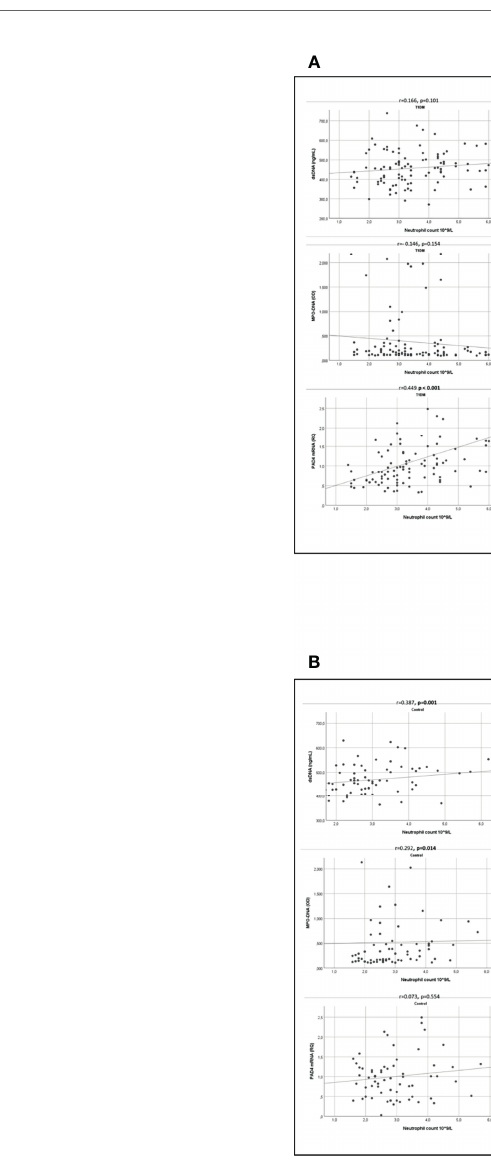
FIGURE 5 | Correlation between NETs markers and neutrophil count. Scatter graphs with trend line showing correlations between markers of NETs and neutrophil count in TIDM (A) and controls (B) . T1DM, type 1 diabetes mellitus; dsDNA, double-stranded deoxyribonucleic acid; MPO-DNA, myeloperoxidase-DNA; H3Cit, citrullinated histone 3; PAD4, peptidylarginine deiminase